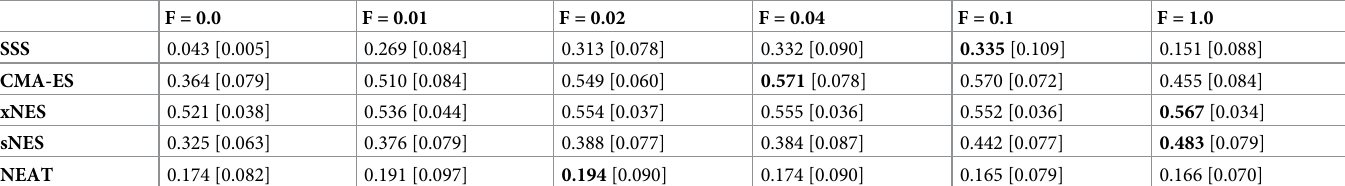
Table 1. Performance of the best solutions post-evaluated for 500 validation episodes for experiments in which the environmental conditions vary with different frequency across generations. F = 1 / G, where G is the number of generations after which the environmental conditions vary. Experiments conducted with NEE = 20. Each number indicate the average result of 40 replications. Numbers in brackets indicate the standard deviations. F = 0.0